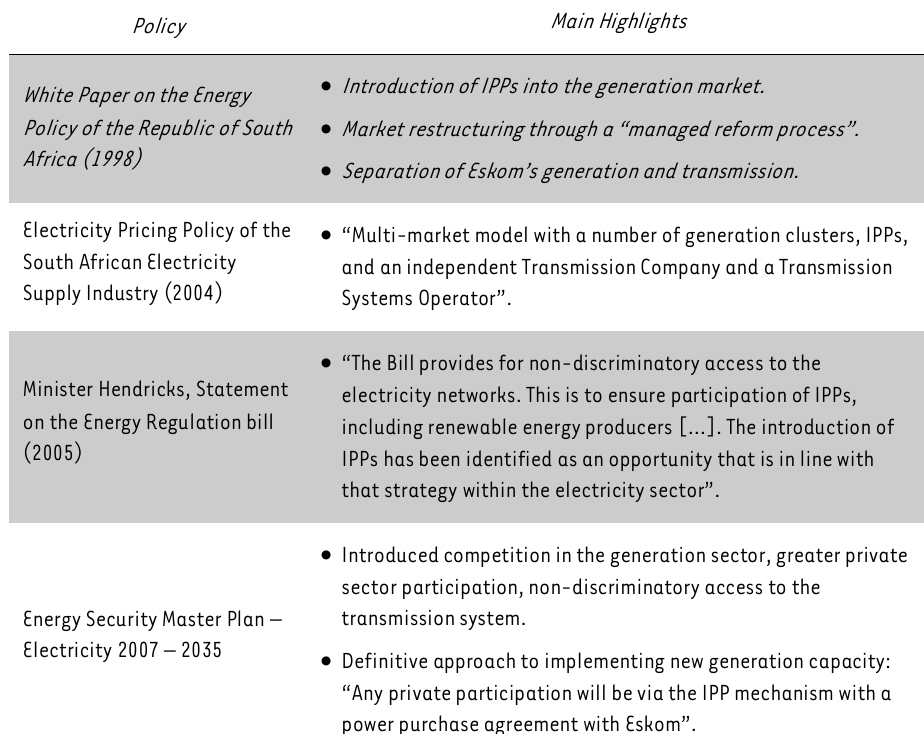
Electricity supply industry policy Policy Main Highlights White Paper on the